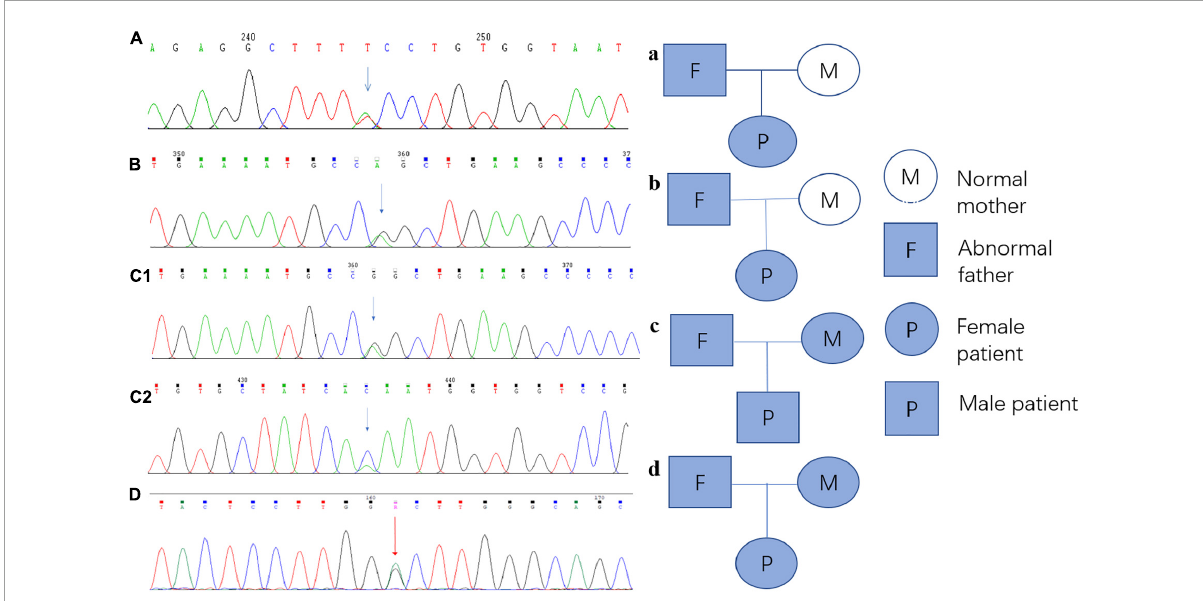
FIGURE4 Sanger sequencing verification diagram and pedigree of the ABCB4 variations in each patient and their parents. (A) Sanger sequencing verification of ABCB4 _ex13 c.1560 + 2T > A in patient 1; a: the pedigree of patient 1 and her parents, and this variation originated from her father. (B) Sanger sequencing verification of ABCB4 _ex17 c.2177C > T (p. Pro726Leu) in patient 2; b: the pedigree of patient 2 and her parents, and this variation originated from her father. (C1) Sanger sequencing verification of ABCB4 _ex17 c.2177C > T (p. Pro726Leu) in patient 3, c1: the pedigree of patient 3 and his parents, and this variation originated from his mother. (C2) Sanger sequencing verification of ABCB4 _ex15 c.1756G > T (p. Val586Leu) in patient 3, c2: the pedigree of patient 3 and his parents, and this variation originated from his father. (D) Sanger sequencing verification of ABCB4 _ex17 c.2171T > C (p. Vol824Ala) in patient 4; d: the pedigree of patient 4, and this variation originated from her